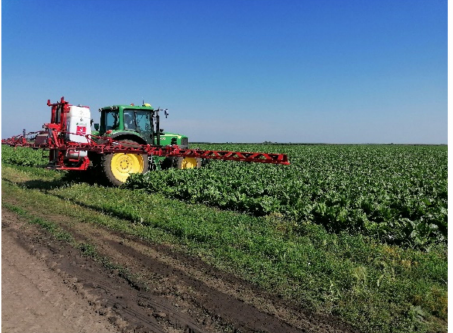
Figure 3. Field treatment (tractor field crop sprayer and sugar beet crop in moment of fungicide